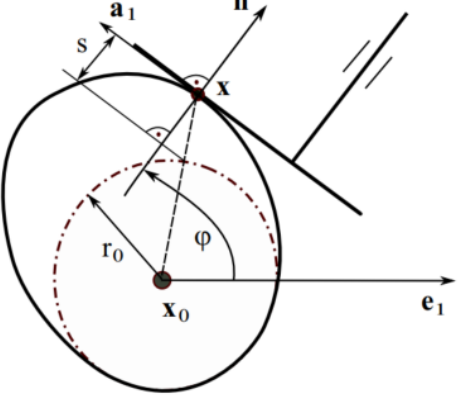
Figure 4. Calculation parameters of cam flat ‐ face follower.